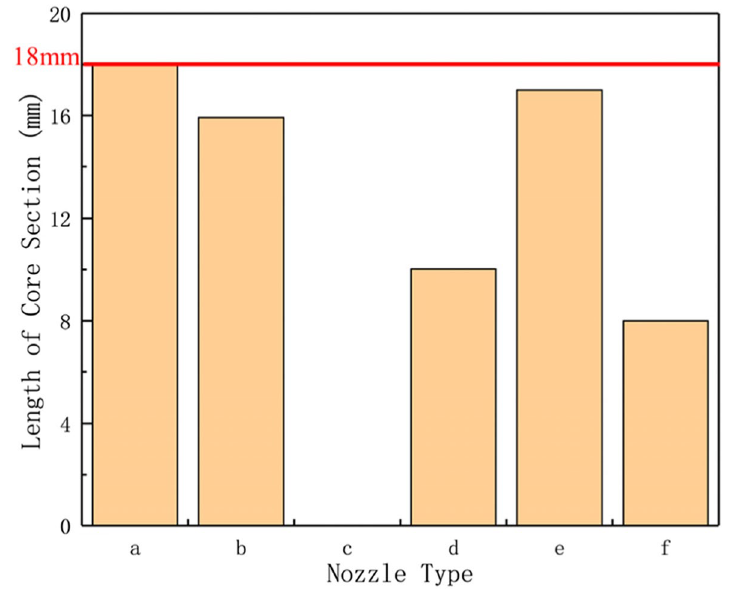
Fig. 11 Length of the core stage of each nozzle